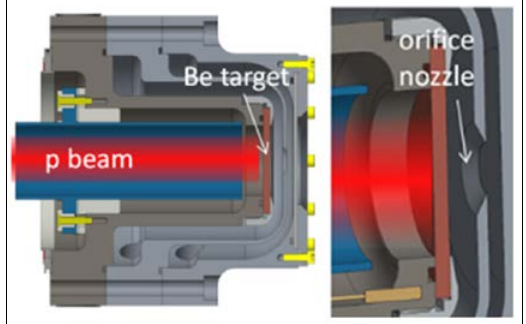
Fig. 5. The target chamber of p-n convertor assembly with orifice- nozzle for the water jet cooling - the prototype